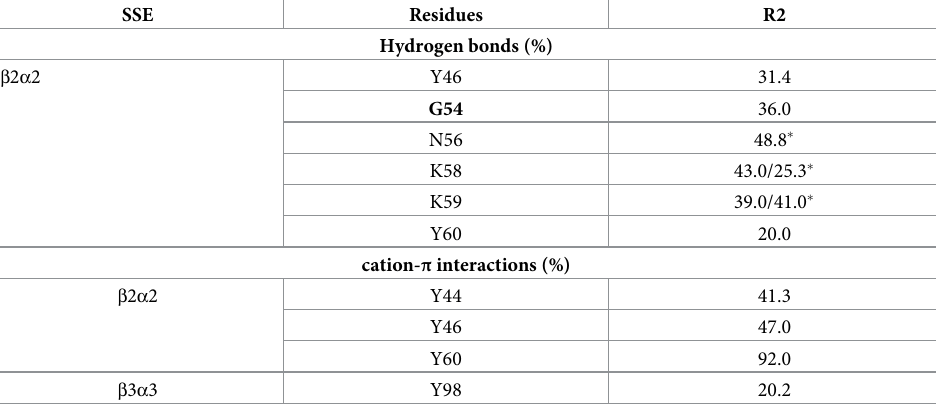
Table 4. Inventory of interactions between Li_ α IA1 (3RLH) and a POPC:POPE bilayer. Hydrogen bonds and cat- ion- π occupancies are reported as percentages. Residues in bold indicate hydrogen bonds involving the amino acid backbone. All numbers are for interactions with POPC lipids, except those marked with an asterisk ( � ) which indicates interactions involving the headgroup of POPE lipids. K58 and K59 interact with both POPC and POPE headgroups. SSE Residues R2 Hydrogen bonds (%) β 2 α 2 Y46 31.4 G54 36.0 43.0/25.3 �